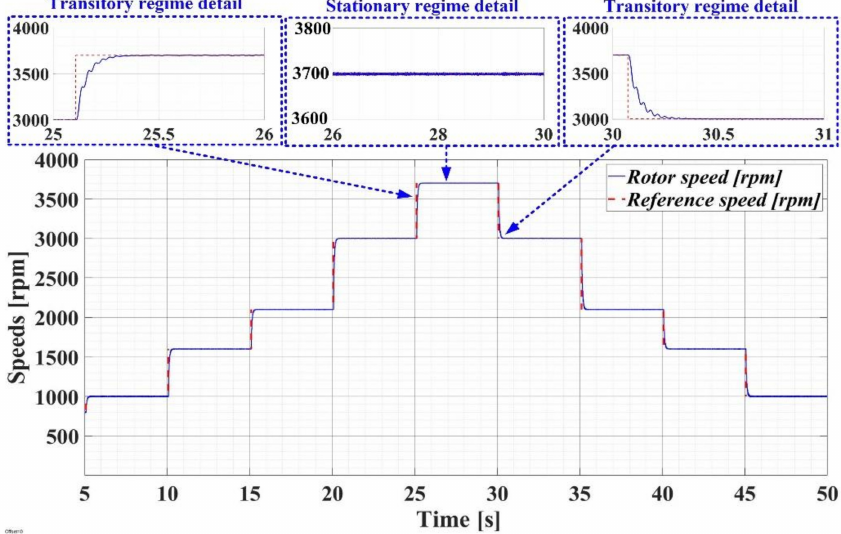
Figure 25. Real-time speed evolution of PMSM–CS–CI based on the LQR-type controller. In addition, the real-time evolutions of stator currents i a and i b are presented in Figure 26, that of the d - q frame current i q is presented in Figure 27, and those of the electromagnetic torque T e and load torque T L are presented in Figure 28.